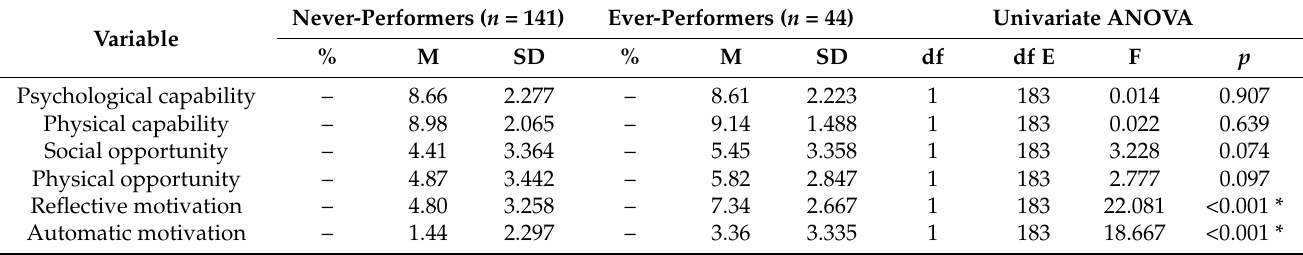
Table 2. Differences between groups for capabilities, opportunities and motivations to use hearing protection.